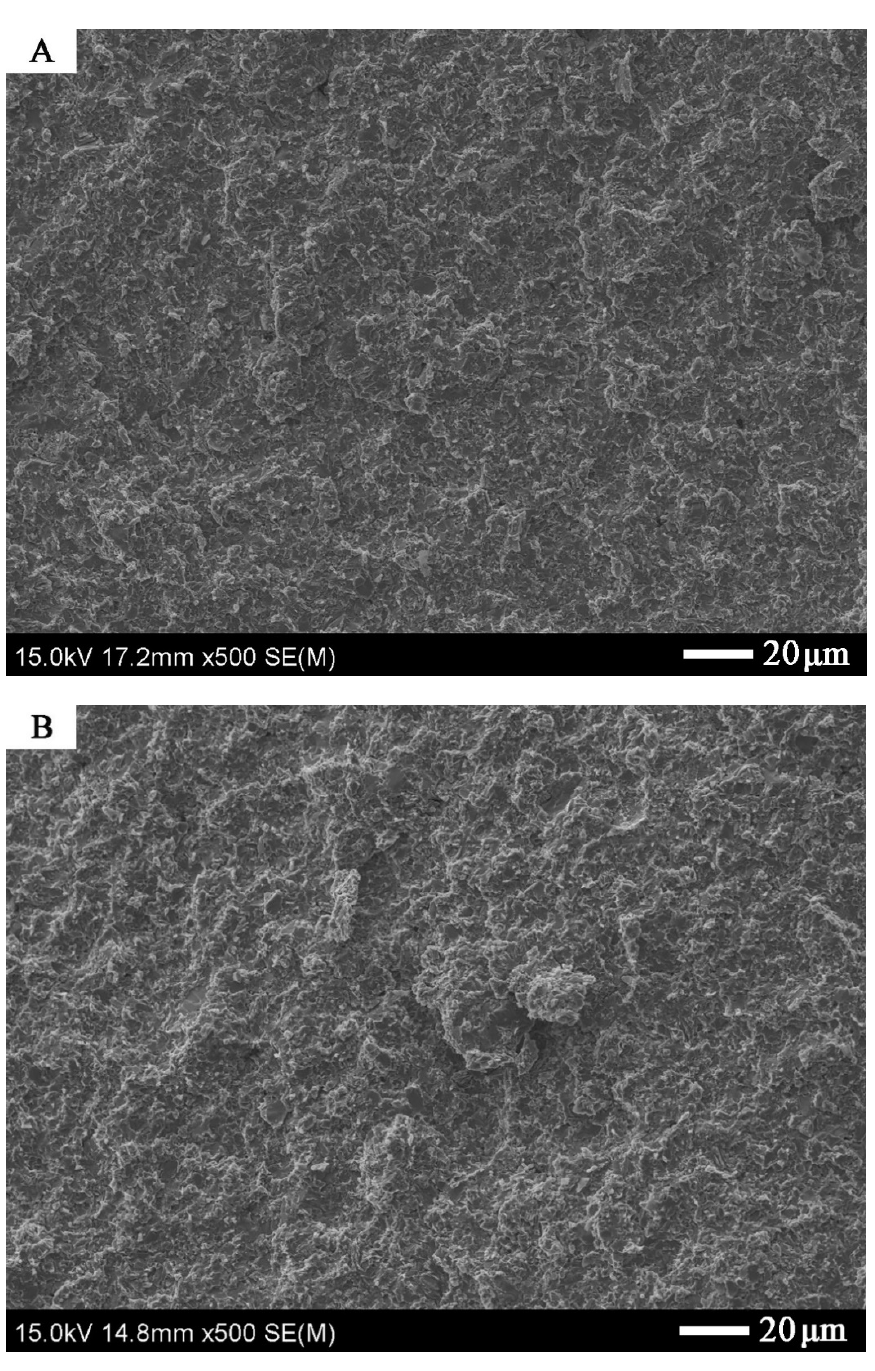
Figure 9. Fractography of tensile fracture surfaces for the extruded Zr-10Cu samples: ( A ) direction of the material is parallel to the extrusion axis (cut “longitudinal”); ( B ) direction of the material is perpendicular to the extrusion axis (cut